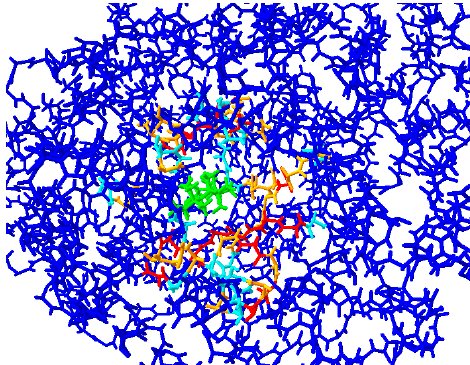
Figure 9. Cherry XP_021819928.1 model was superimposed on its docked structure with dammarenyl cation for the determination of backbone RMSD of all residues due to induced-fit docking. Blue, 0 RMSD; cyan, RMSD between 0.05–0.1 Å; orange, RMSD between 0.1–0.2 Å; red, RMSD > 0.2 Å. Dammarenyl cation ligand is shown in green.